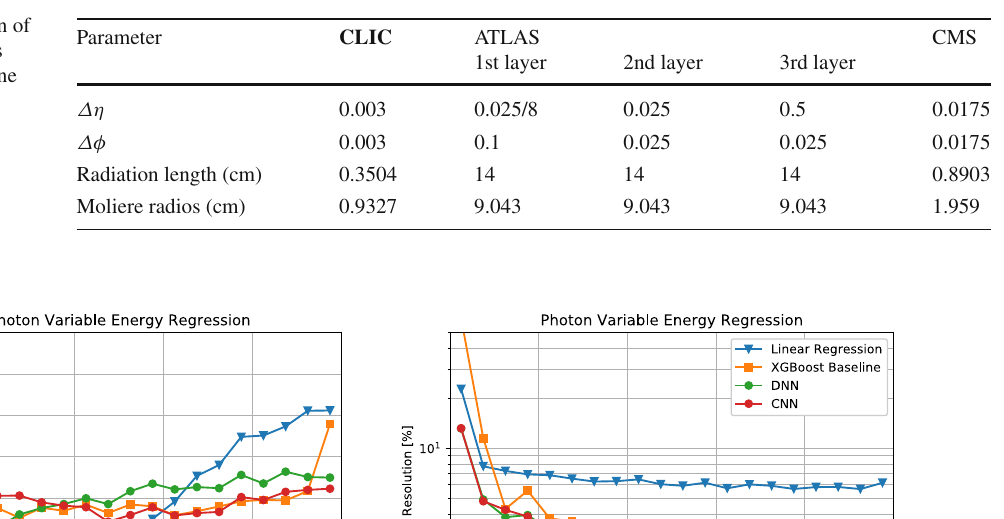
tors. This difference determines an offset in the fine